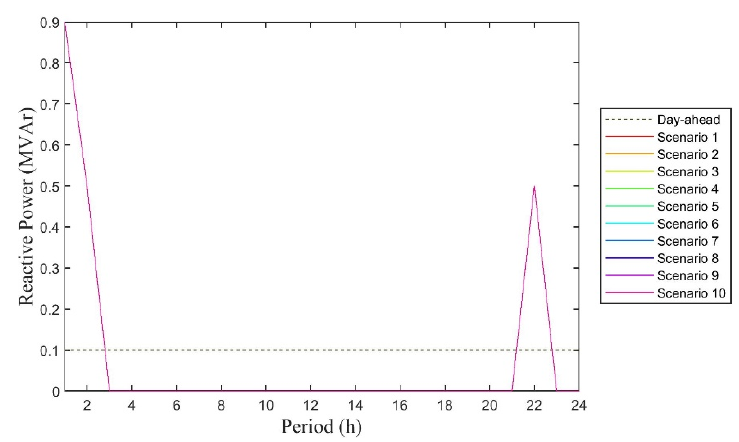
Figure 7. Reactive power production of capacitor bank 2 throughout 24 hours.